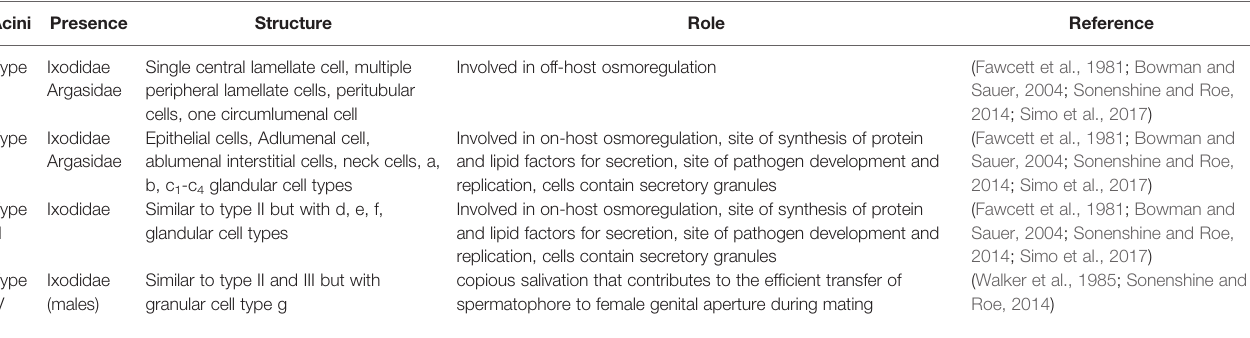
TABLE 1 | Tick salivary gland type I, II, III and IV acini structure and